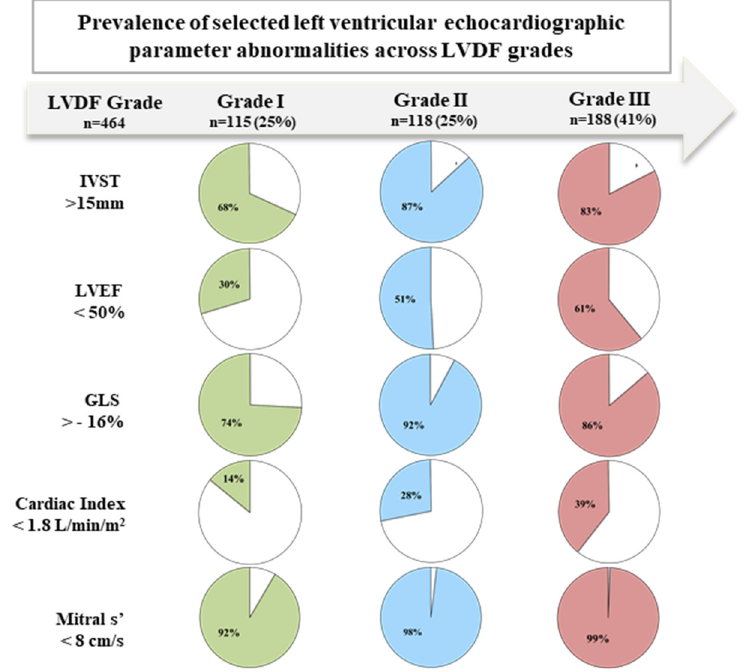
Figure 3. Prevalence of selected echocardiographic parameters abnormalities across left ventricular diastolic function grades. Coloured portions: positive criterion (beyond the cut-off value) GLS: global longitudinal strain; IVST: inter-ventricular septal thickness; LVDF: left ventricular diastolic function; LVEF: left ventricular ejection fraction; s’: systolic pulsed-wave tissue Doppler imaging at the mitral annulus.